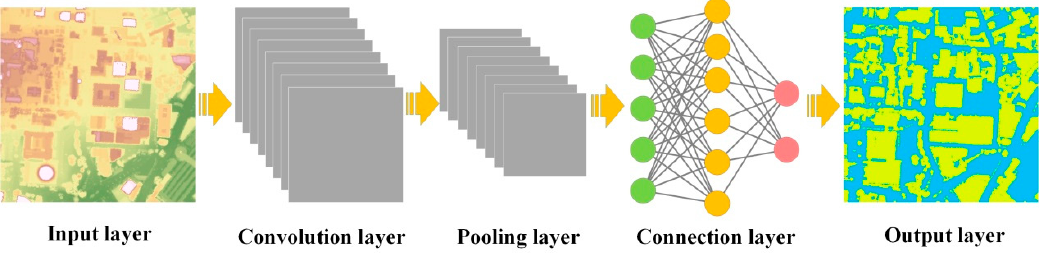
Figure 5. Structure of convolutional neural networks-based filters.